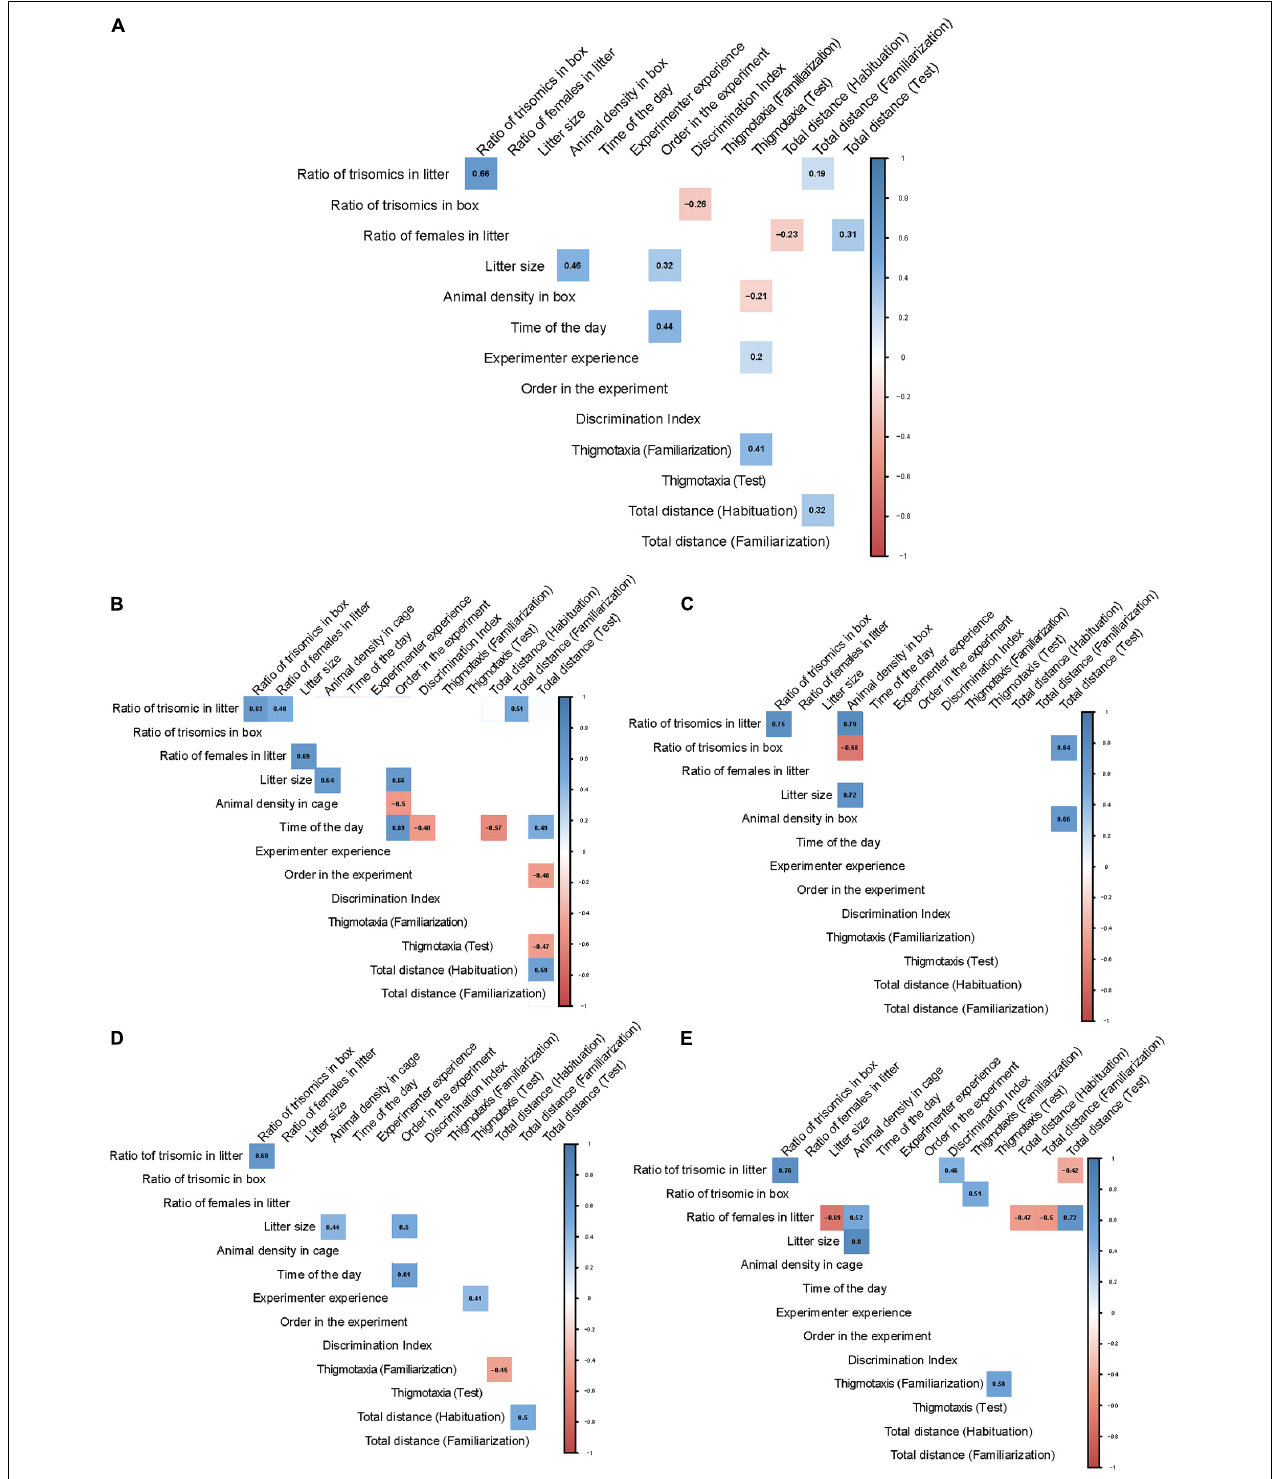
FIGURE 3 | Correlograms showing partial correlations across the different groups of mice. Environmental factors and behavioral readouts are arranged in rows and columns. The correlation between variables is represented at their intersection with the correlation coefficient inside a colored square. The color of the square indicates if the correlation is positive (blue) or negative (red) and the color intensity, the weight of the correlation. The intersections in which the correlations did not reach significance ( p -value > 0,05) were not colored. (A) Partial correlations corresponding to all mice tested. (B) WT males; (C) Trisomic male; (D) WT females; (E) Trisomic